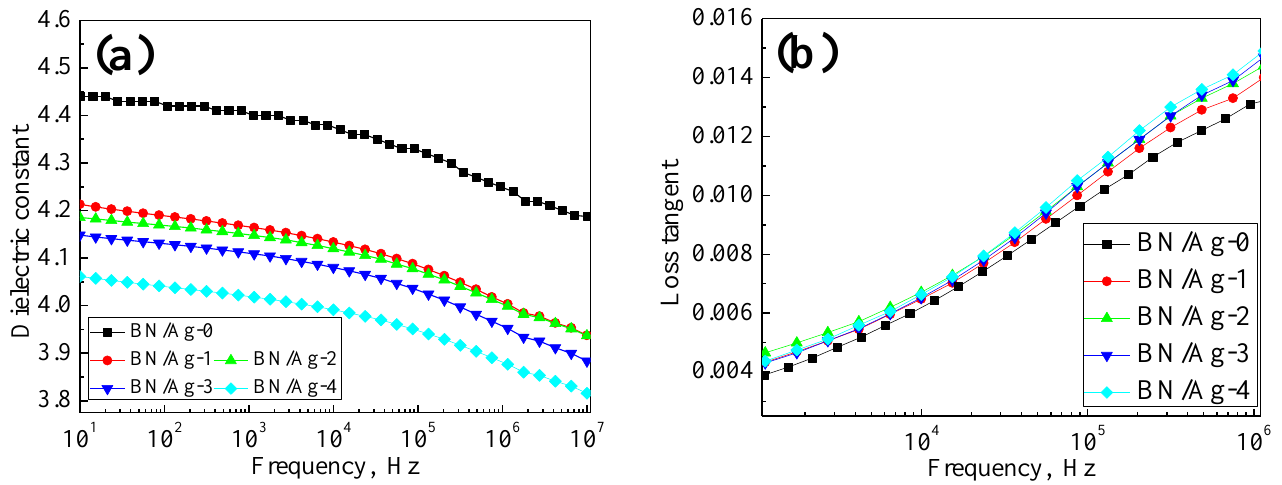
Figure 9. ( a ) Dielectric constant of Composites ( b ) Dielectric loss of